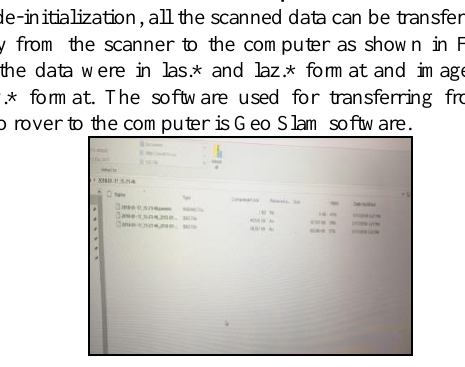
Figure 8. Raw data from rover transferred to the computer